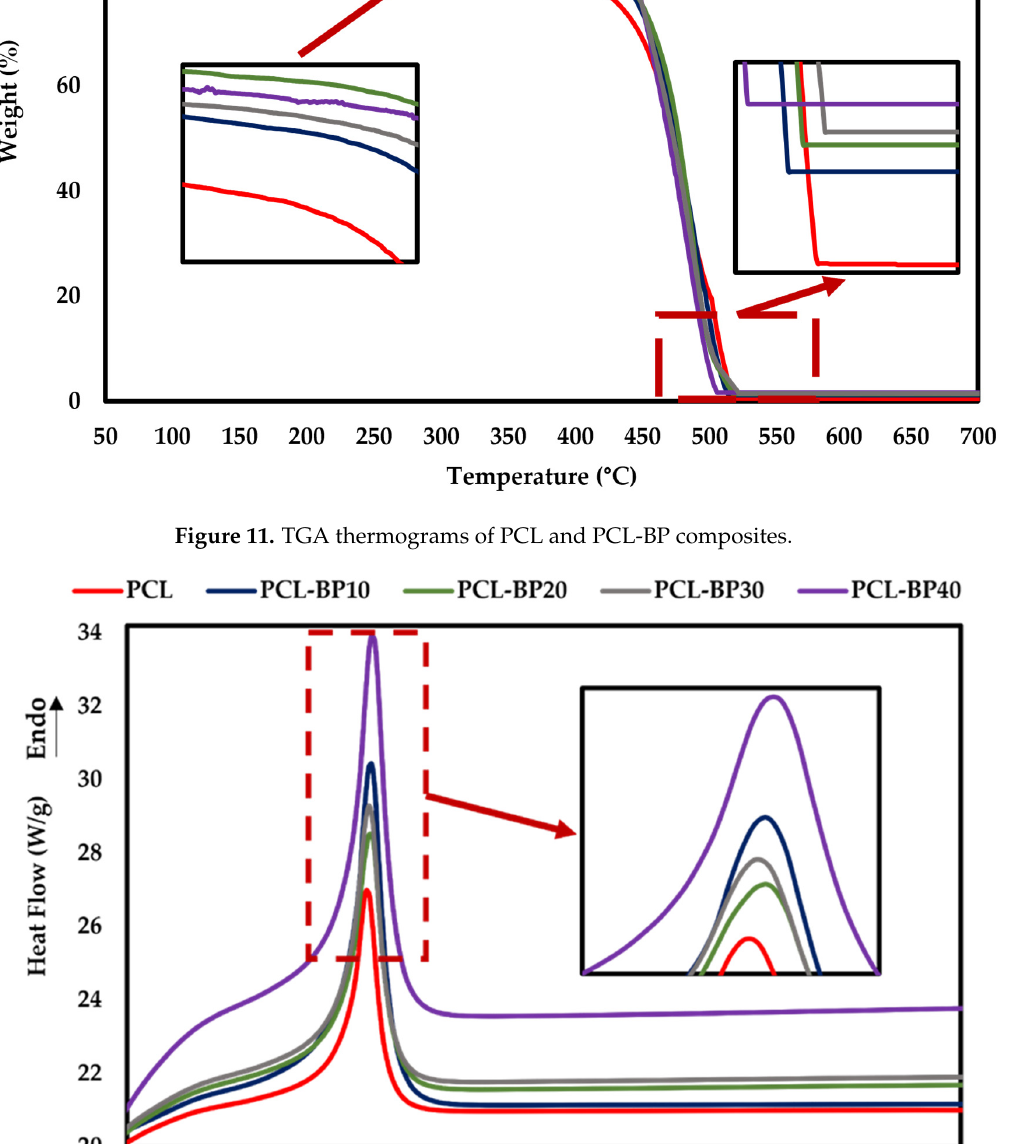
Table 3. Melting temperature (T m ) and enthalpy of melting ( Δ H m ) of PCL-BP composites.